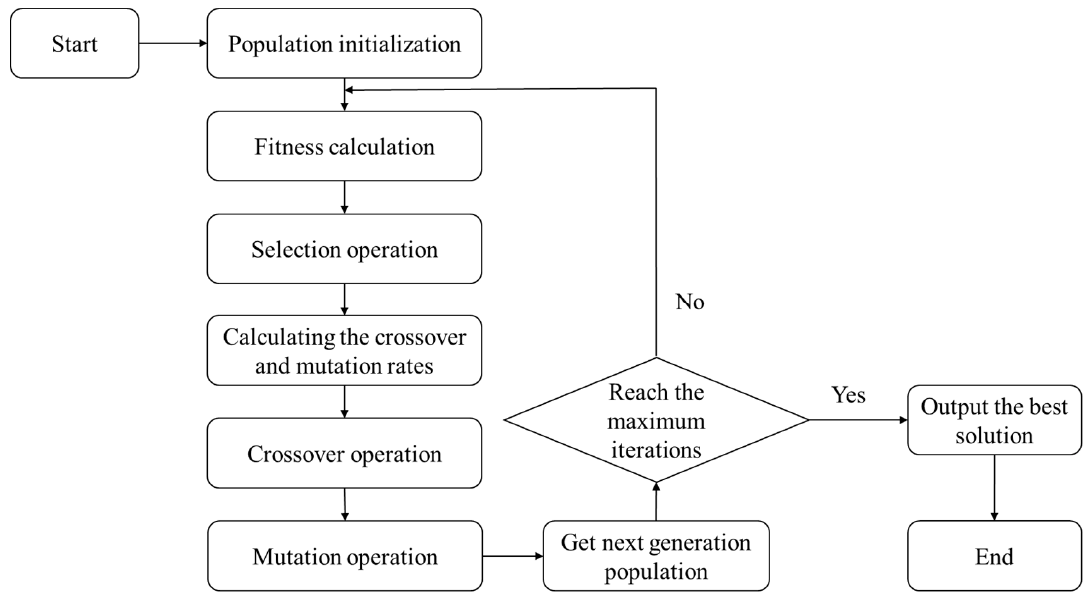
Figure 1. The work fl ow of